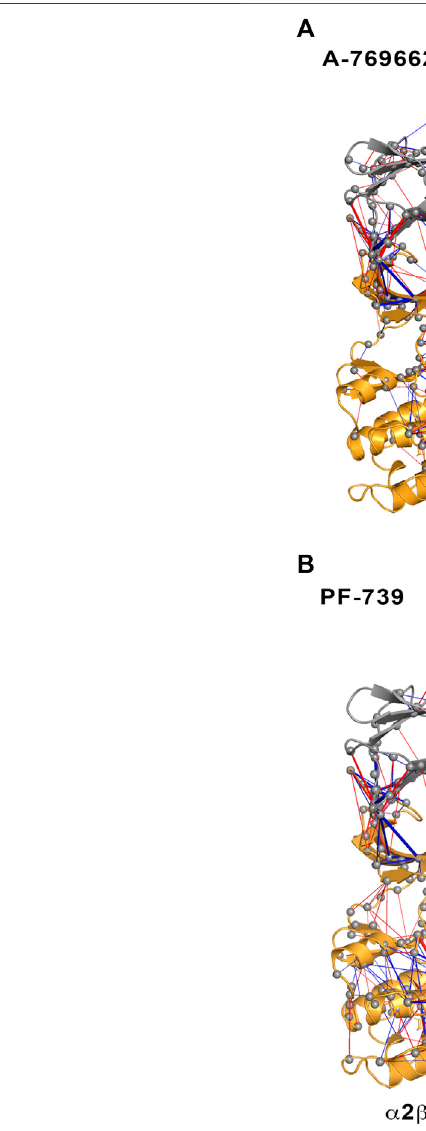
FIGURE 5 | Representation of the contact changes observed in the dynamical perturbation network between apo and holo states for (left) α 2 β 1 and (right) α 2 β 2 species.Theholostateswerecalculatedinpresenceof (A) A-769662and (B) PF-739activators.Red/blueedgesshowinterresidueatomiccontactincrease/decreasein the holo state relative to the apo form. The magnitude of these changes is indicated by the width of the edges.